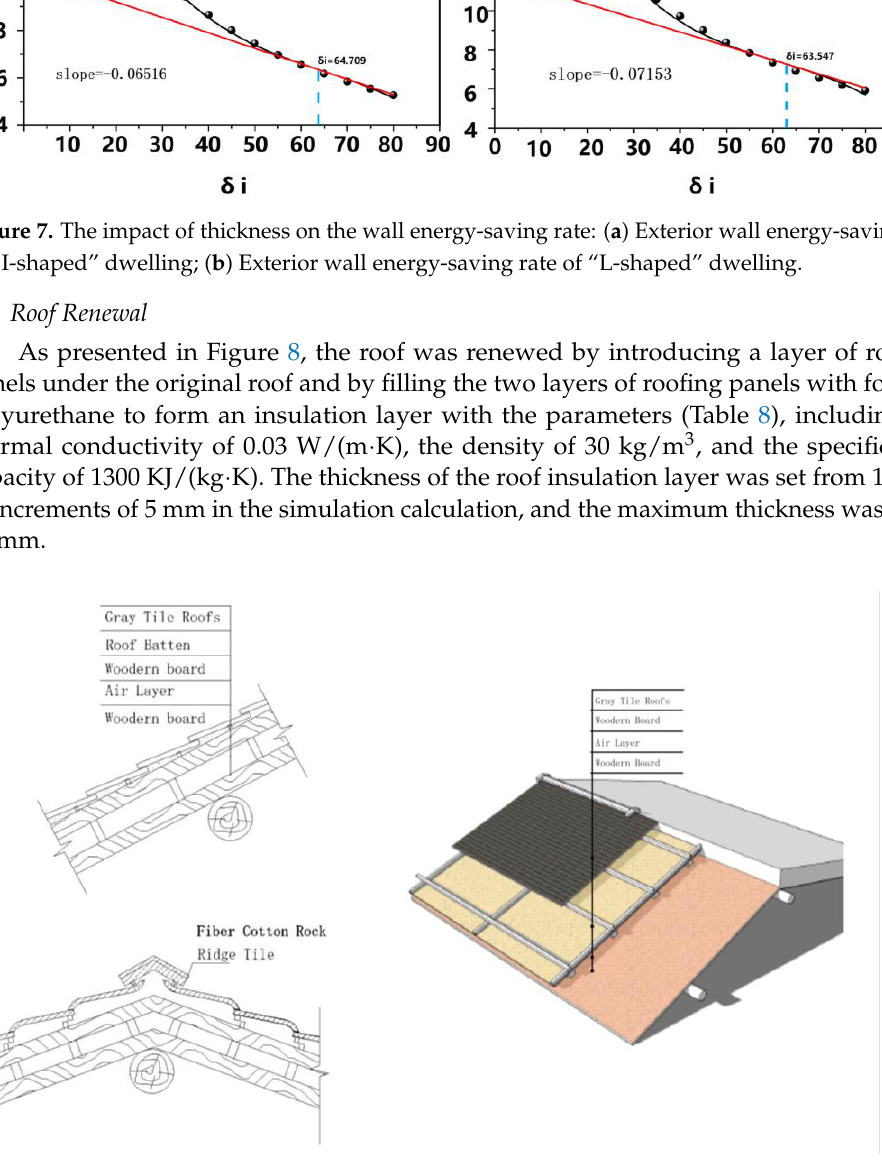
Figure 8. Roof renewal method. Table 8. Material settings of the dwelling envelope retrofitting.